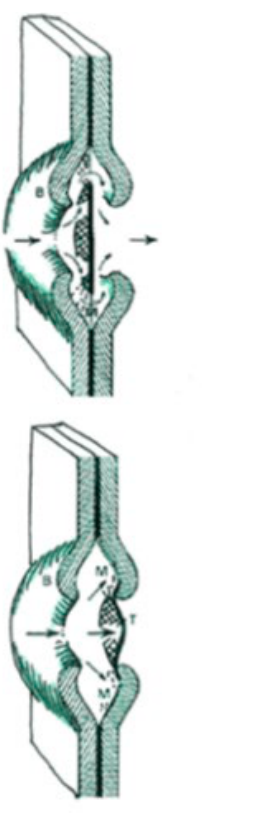
Figure 2. Diagramme of the workings of a bordered pit: when func- tioning normally (top), the water skirts the central impermeable zone of the shared membrane and enters the neighbouring tracheid; in the case of a wound with air bubbles (accidental entry of air), the relative increase in pressure causes the membrane to be flat- tened, by suction, against the inside of the opposite pit (bottom), blocking the flow of water in the damaged part [modifies after Zim- mermann 1983]. The recent discoveries about water encourage the supposition that this forced passage through the fibrillar weave of the peripheral membrane confer on the water an additional propor- tion in the ‘cristalline-liquid’ phase with high viscosity and lowered freezing point, an essential characteristic for species growing in cold